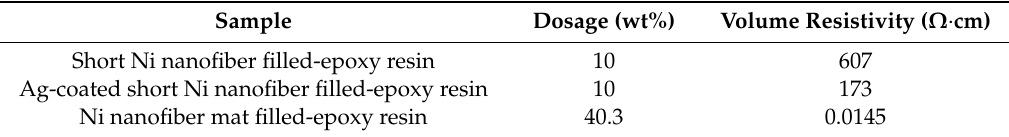
Table 1. ρ v values of epoxy nanocomposites filled with di ff erent kinds of conductive fibers.